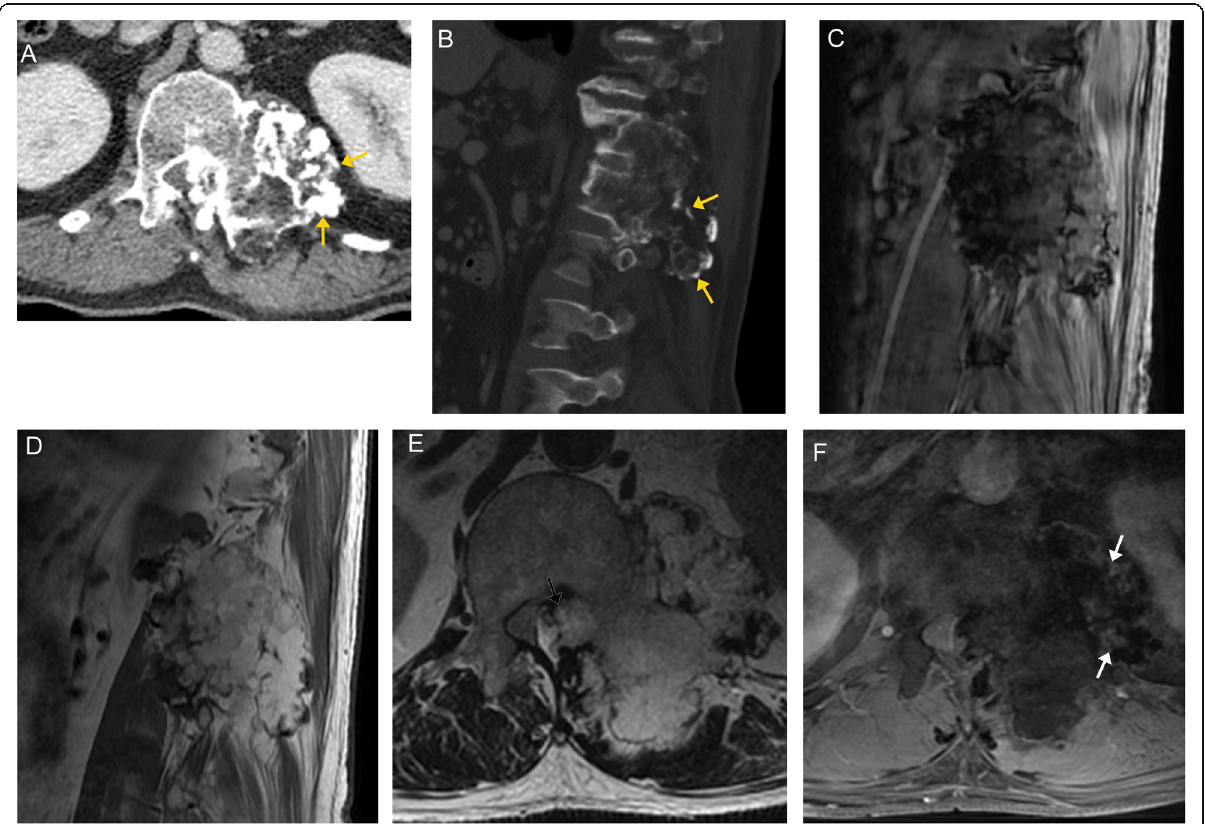
extending over multiple vertebral levels. Sagittal GRE image ( c ) demonstrates areas of low signal within the tumor, due to its calcific components. Sagittal T1-weighted image ( d ) demonstrates variable signal intensity of the tumor. Axial T2-weighted image ( e ) demonstrates lobular, predominantly high signal intensity of the tumor due to the high-water content of hyaline cartilage. Additionally, there is epidural extension of the tumor (black arrow), displacing the spinal cord. Peripheral areas of low signal intensity are due to calcifications. The T1 fat-suppressed post- contrast image ( f ) demonstrates enhancement along the periphery and internal septa (white arrows). The non-enhancing areas represent